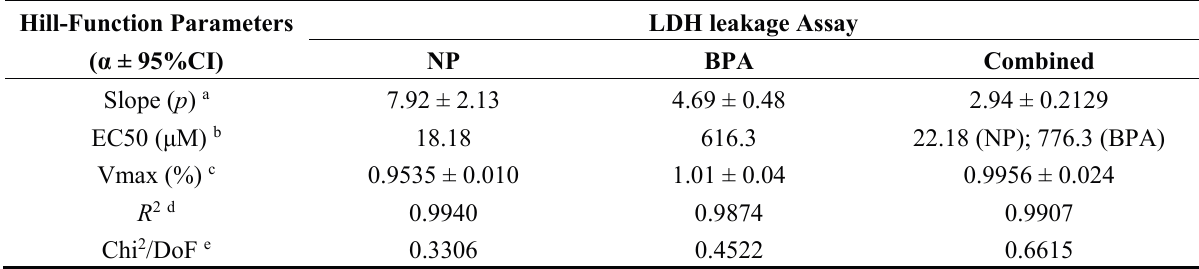
Table 2. The concentration-response curve of lactate dehydrogenase (LDH) leakage rate assay satisfying the Hill function of the chemicals nonylphenol (NP) and bisphenol A (BPA) alone or in